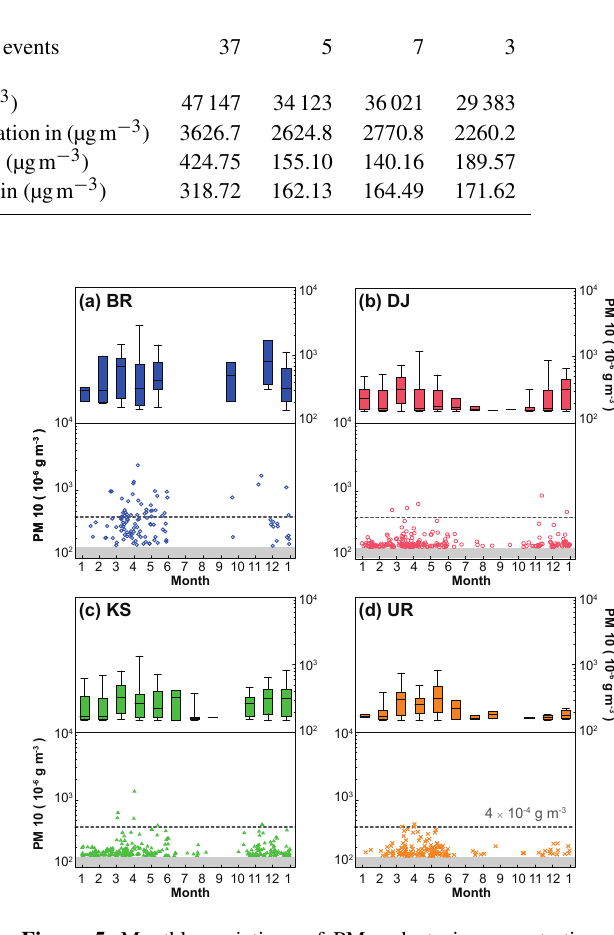
Figure 5. Monthly variations of PM 10 dust air concentration at (a) BR, (b) DJ, (c) KS, (d) UR. The lower panel shows a distri- bution of individual PM 10 dust air concentration. Data symbols and reference lines are as in Fig.